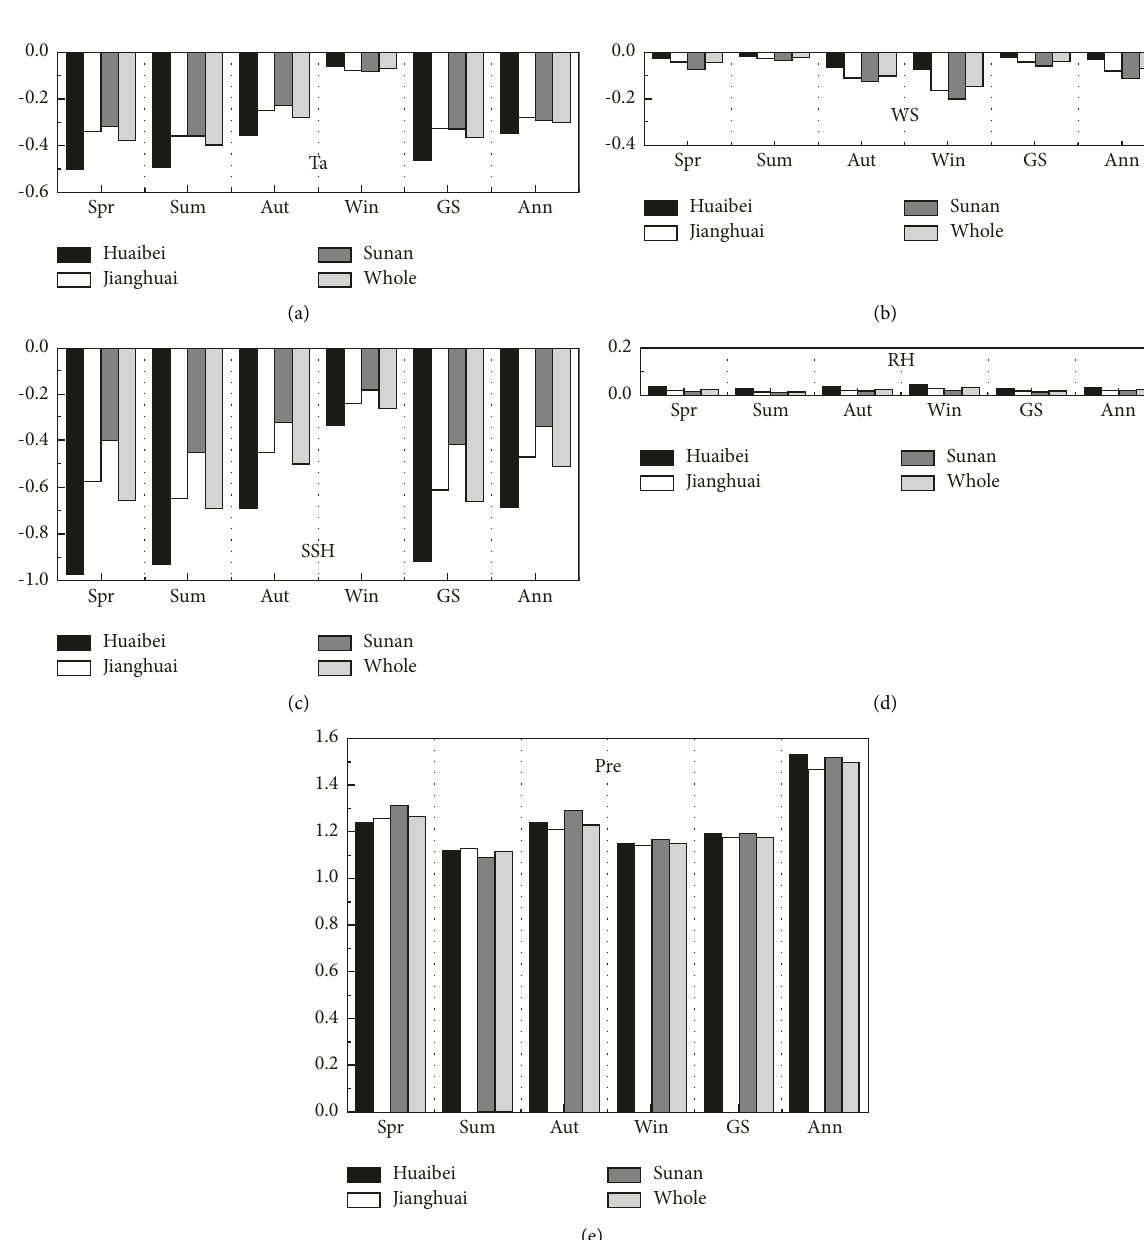
Figure 4: Sensitivity coefficients of seasonal and annual humidity index (HI) to five principal meteorological parameters in each region and the entire province; T a , WS, SSH, RH, and Pre are mean daily air temperature, wind speed, sunshine hours, relative humidity, and precipitation,